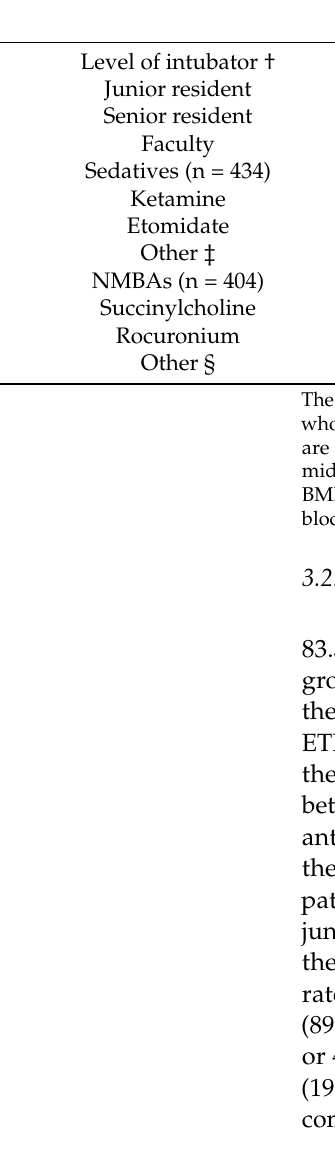
Table 2. Primary and secondary